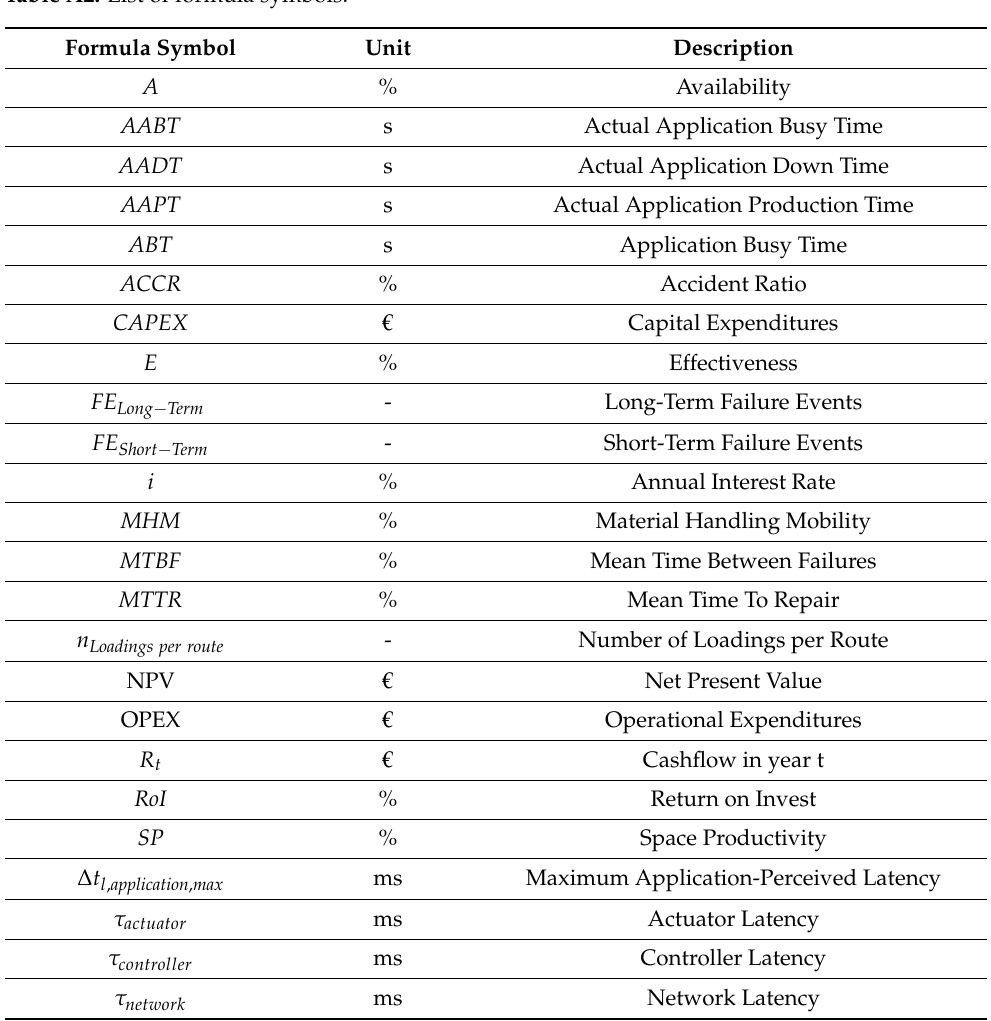
Table A2. List of formula